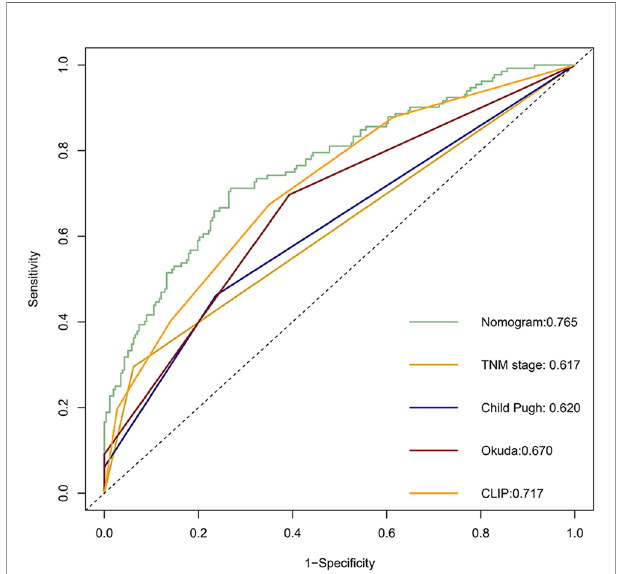
FIGURE 6 | The time-dependent receiver operating characteristic (tdROC) curve of the prognostic nomogram in the validation group.